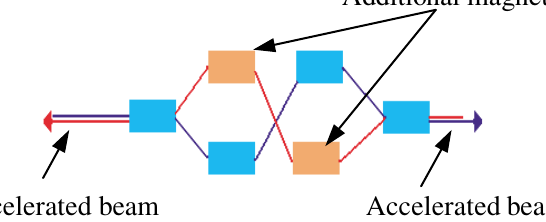
FIG. 8. (Color) Schematic layout of the modified bunch com- pressor BC III of DESY design to provide beam separation.